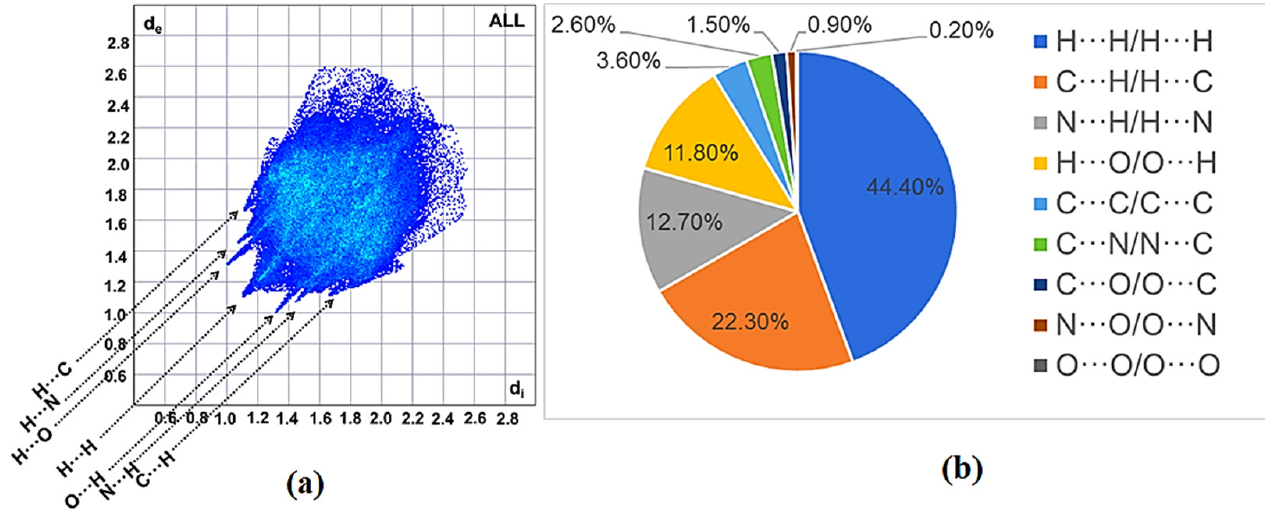
Figure 6. ( a ) The fingerprint plot of 2 and ( b ) the percentages of elemental contacts.